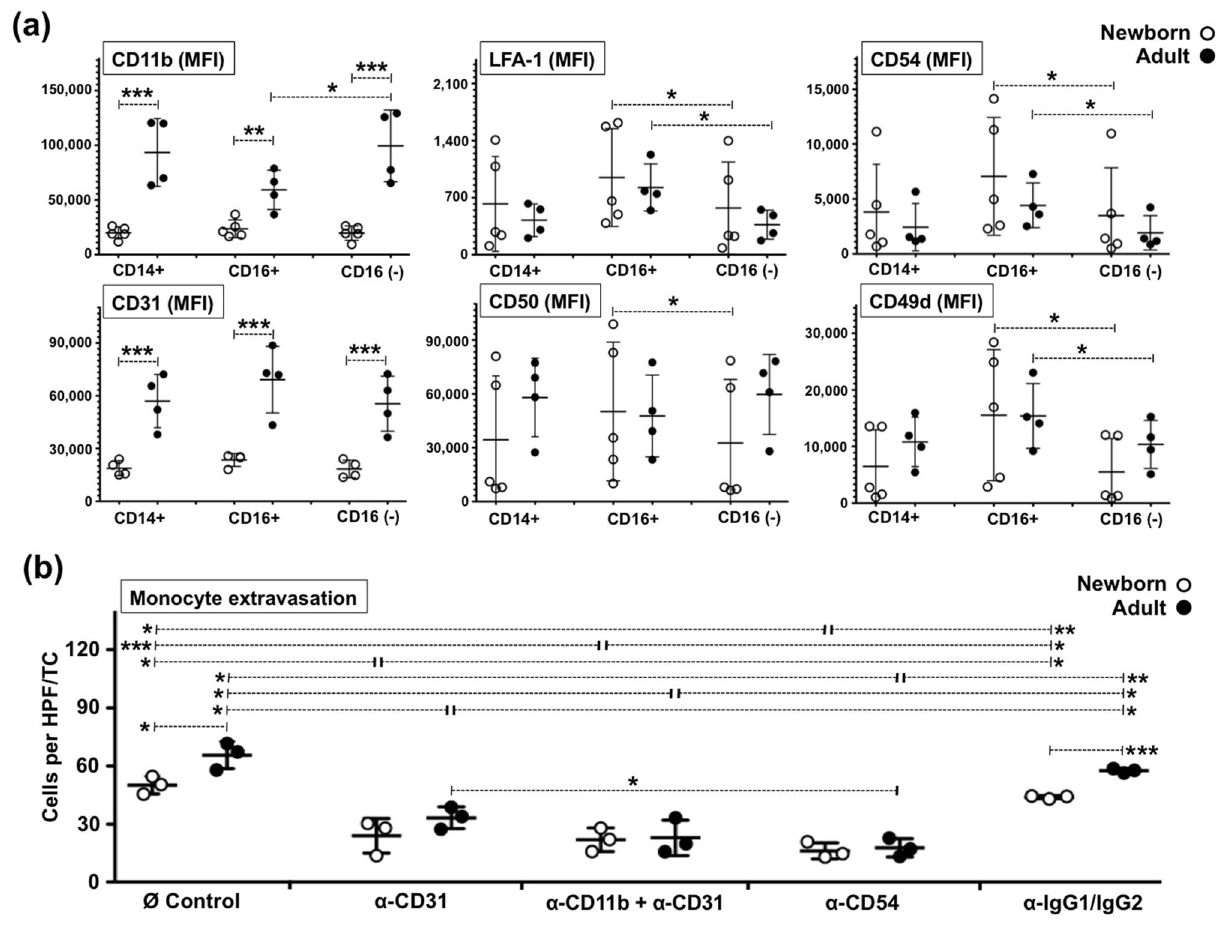
Figure 6. Neonatal monocytes express lower levels of functional CD11b and CD31. ( a ) The surface expression (MFI) of CD11b, CD31, CD54, CD50, CD49d and LFA-1 was studied on fresh newborns and adult monocytes using flow cytometry and analysed as total, CD16− and CD16+ monocytes (N = 4–5/age-group). MFI Mean Fluorescent intensity. ( b ) endothelium, as described in methods. HPF High-Power Field. Paired t-Test, two- tailed was used for comparisons between same donors. UnPaired t-Test, two-tailed was used to compare age groups. *P ≤ 0.05; ***P ≤